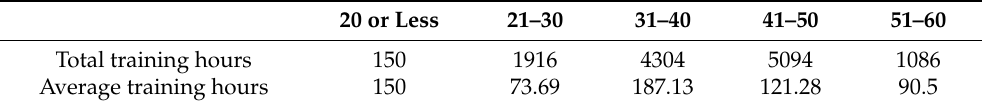
Table 1. Hours of training by age group.